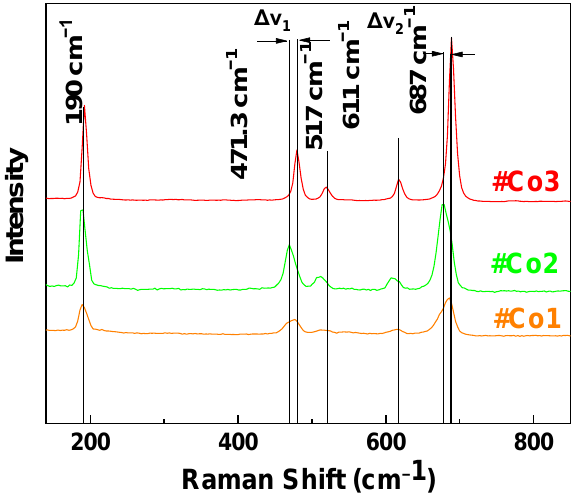
Figure 2. Raman spectra of the FSP-made Cobalt Oxide nanocatalysts. Material #Co3 displayed distinct Raman peaks at 471.3 cm −1 , 517 cm −1 , 611 cm −1 and 687 cm −1 , in accordance with a mixed-phase CoO/Co 3 O 4 [60]. Notice that, the Raman peaks due to CoO are dominating the Raman spectrum of #Co3, despite the lower CoO percentage, i.e., estimated ratio CoO/Co 3 O 4 is 34/66 according to XRD. Since the